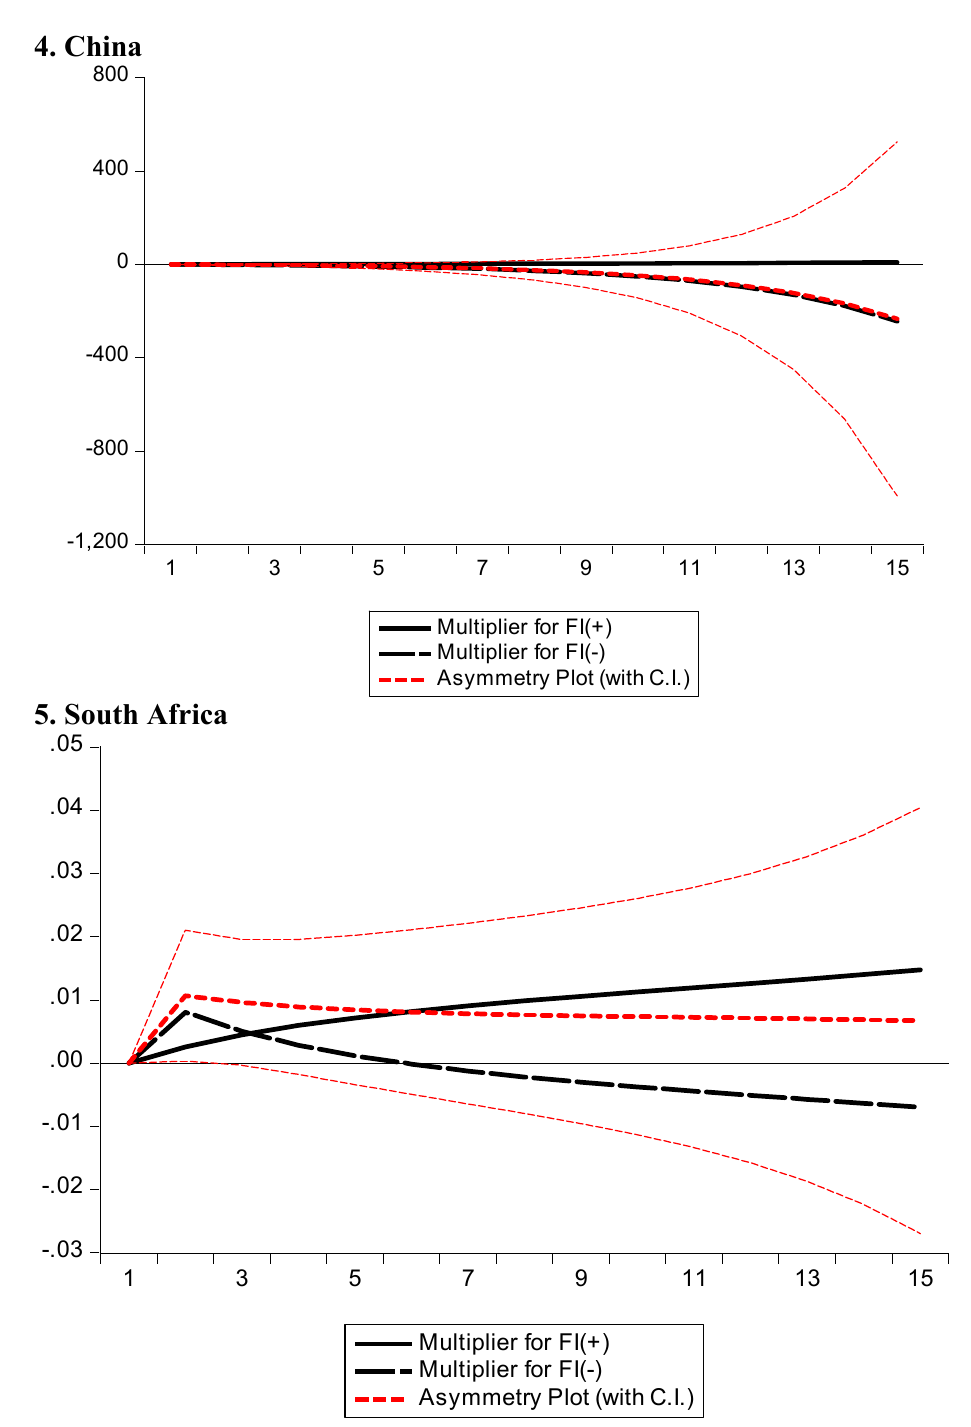
Figure 1. Multiplier graph for renewable energy consumption. The long-run coefficient estimates of NARDL show that the positive component of foreign capital inflow (FCI_POS) increases non-renewable energy consumption in all BRICS economies except India. The coefficient estimates show that a one percent increase in foreign capital inflow enhances non-renewable energy consumption by 0.32 percent in Brazil, 2.27 percent in Russia, 3.93 percent in China, and 0.10 percent in South Africa. These findings are also consistent with Sadorsky [31] and Salim et al. [23], who noted that foreign capital inflows raise non-renewable energy consumption in the host countries. This finding is consistent with Shahbaz et al. [32], who noted that foreign capital